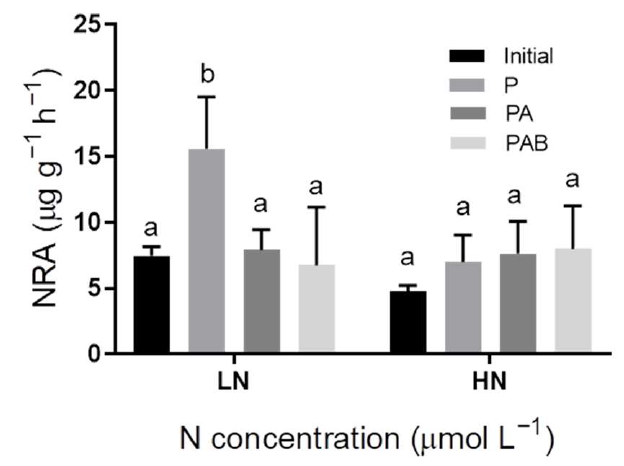
Figure 9. NRA of Sargassum horneri under P, PA, and PAB treatments. Significant ( p < 0.05) differences among the treatments are indicated by different lowercase letters.